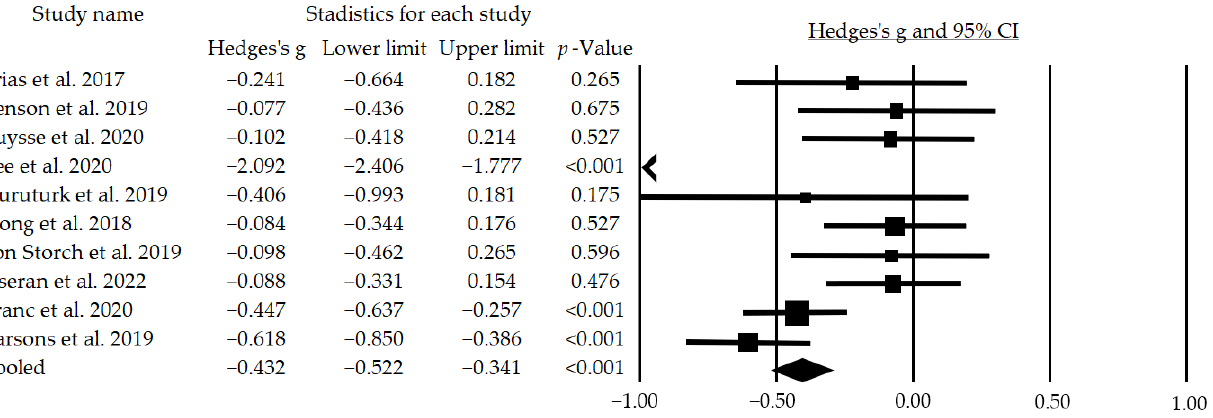
Figure 2. Effects of telemedicine on HbA1c in people with diabetes. The black box represents the point estimate for the respective study, while the size of the box represents the population size and the horizontal line is the 95% CI. The diamond-shaped figure represents the estimated point of the mean effect size.